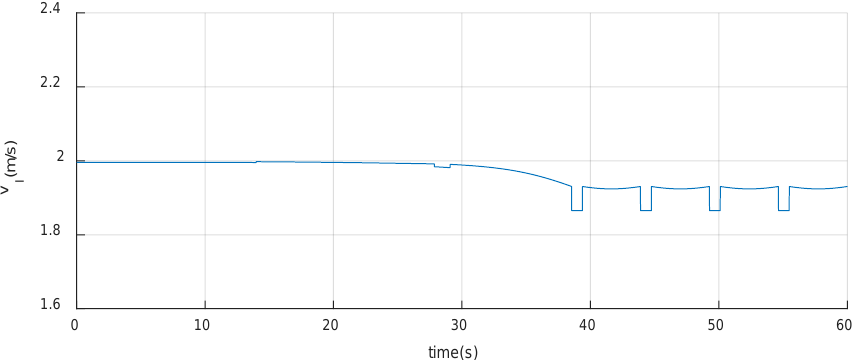
Figure 21. The variation curve of v l for the leader during the movement.